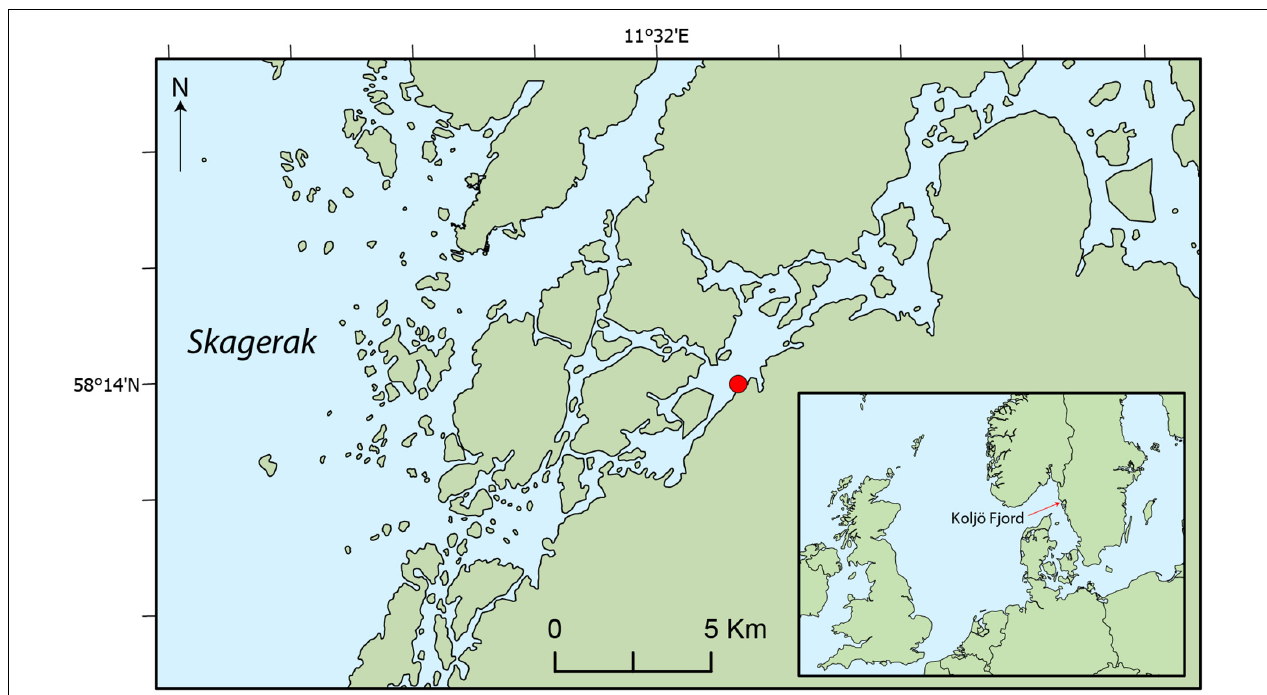
FIGURE 1 | Map showing the Koljö Fjord sampling site on the west coast of